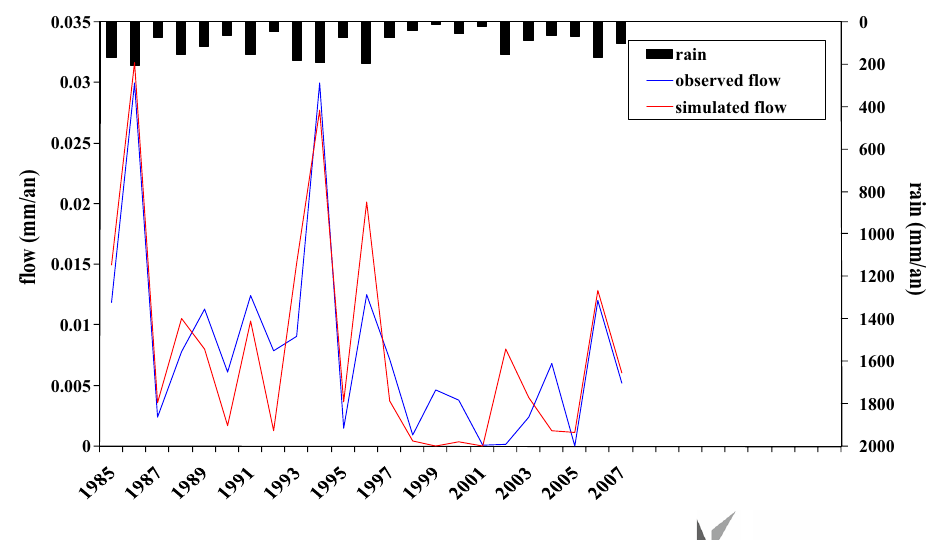
Fig. 3 Visualization of the calibration quality